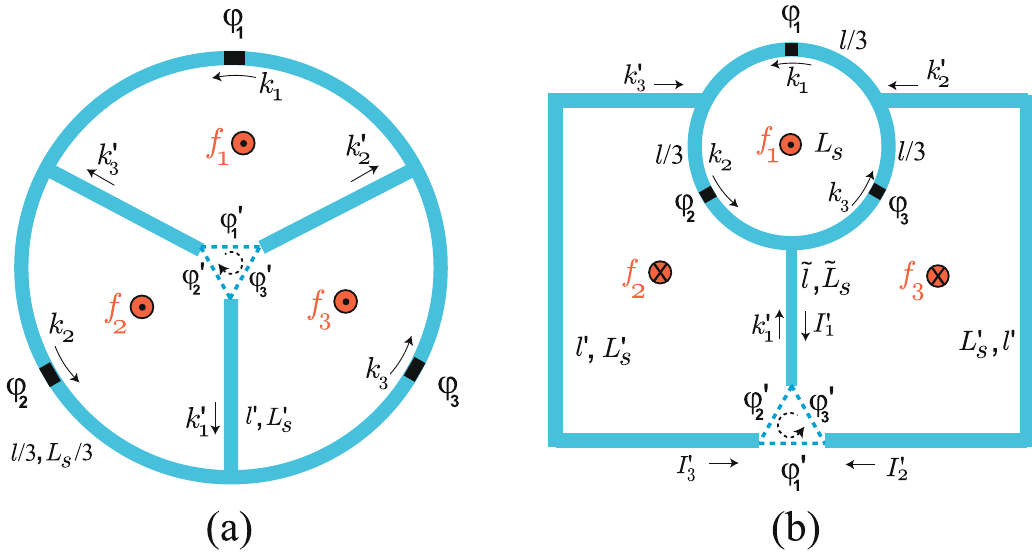
Figure 1. ( a ) Three-Josephson junction loop with length l and geometric inductance L s has three Josephson junctions with phase differences ϕ i and three branches with length l ′ and geometric inductance L ′ s . k i and k ′ i are the wave vectors of the Cooper pairs and f i the external flux threading the loops. ϕ ′ i ’s are the trijunction phase differences. ( b ) A scheme that three branches and trijunction are extracted out from the three-Josephson junction loop and turned over: left and right branches have length l ′ and geometric inductance L ′ s and central branch ˜ l and ˜ L s . Two schemes in ( a , b ) are topologically equivalent with each